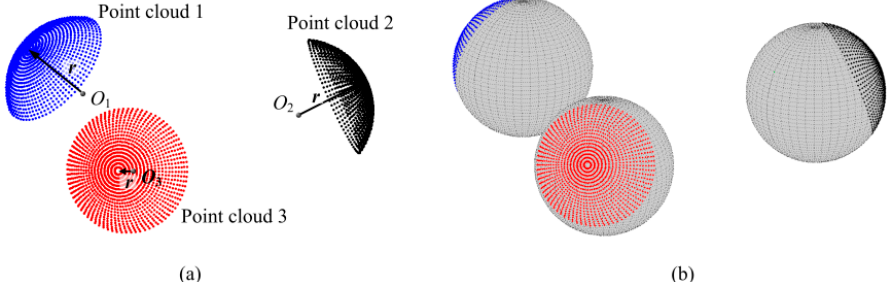
Figure 1. Construction of a sphere surface, ( a ) three point clouds measured from different perspectives of the same sphere target; ( b ) three sphere surfaces constructed by the measurement data of a part of a target.